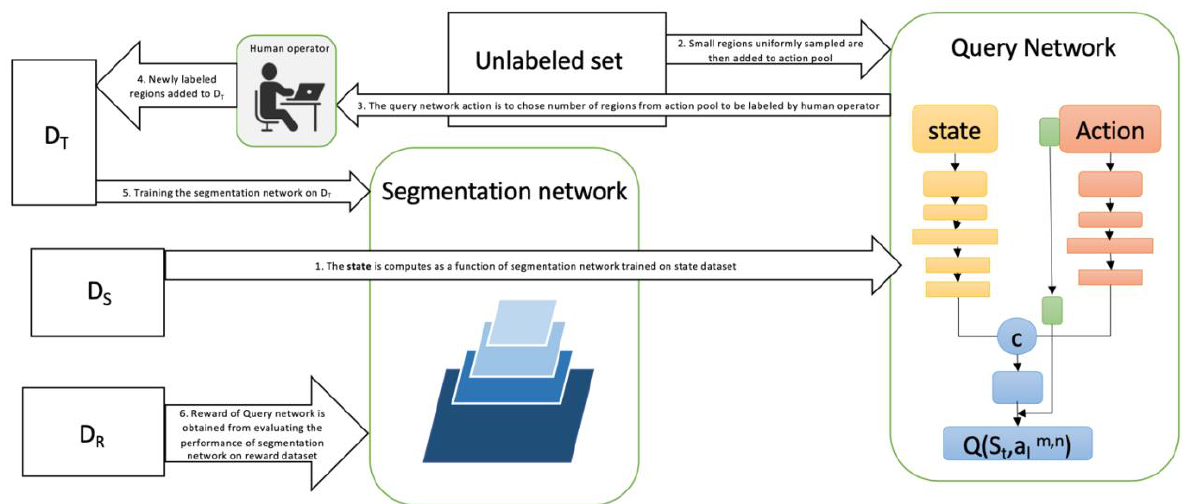
Figure 2. The connections between the query network and segmentation